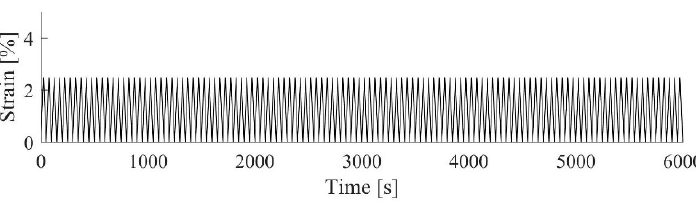
Figure 6. Loading protocol 3 (frequency 0.02 Hz) used for specimens S 31 , S 32 .